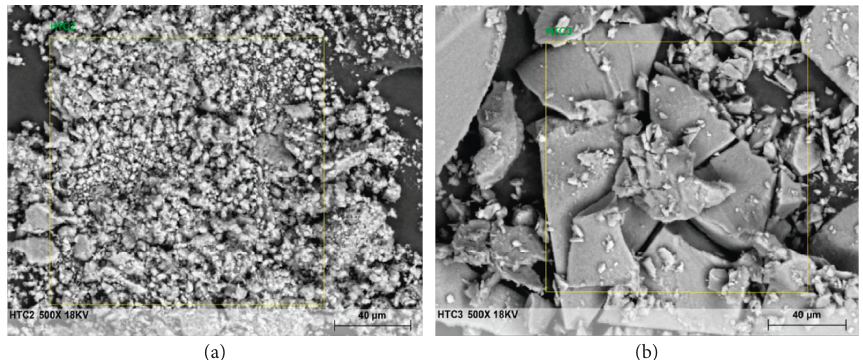
Figure 7: SEM micrograph of activated hydrotalcites M2 (a) and M3 (b) at 500x and at 1200x.